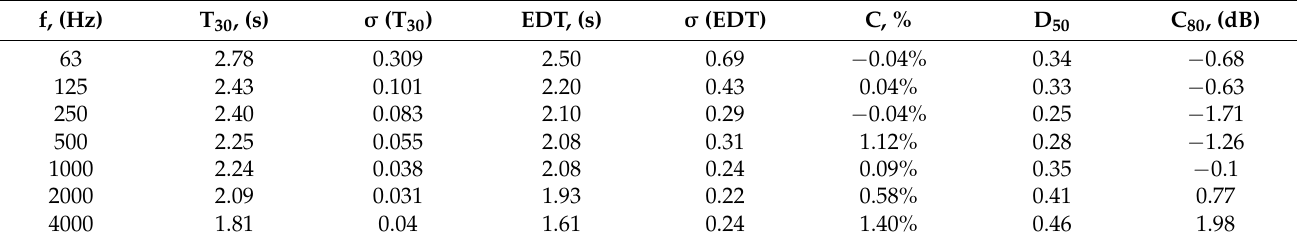
Table 5. Reverberation times and energy ratios (audience).